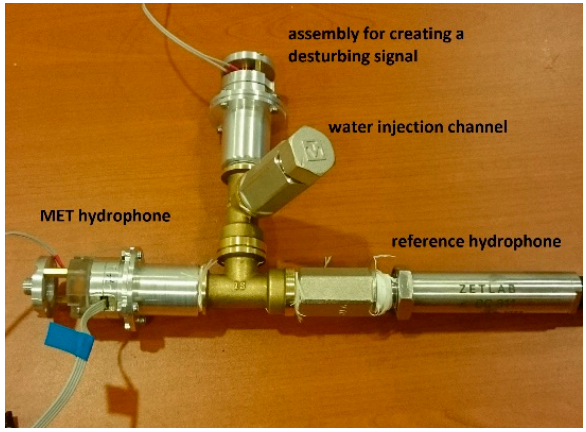
Figure 3. The hydraulic bench.